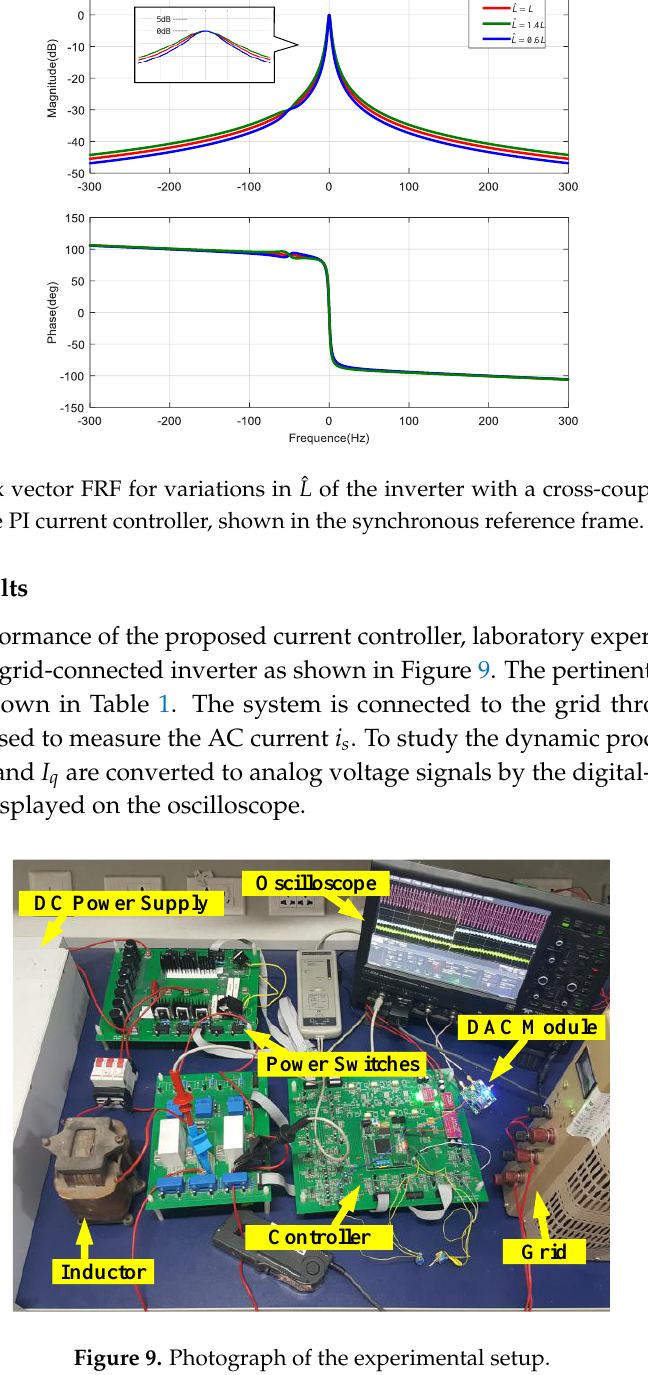
Figure 9. Photograph of the experimental setup.